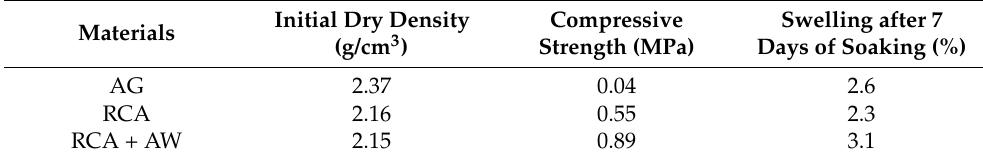
Table 6. Accelerated swelling of study specimens.